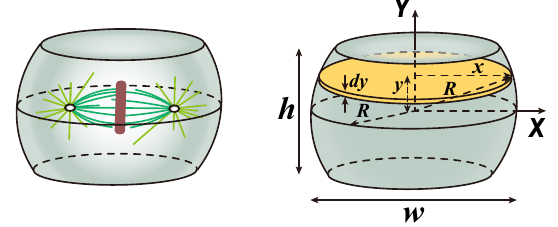
FIG. 7. Schematic for the cell under the two-wall confinement.